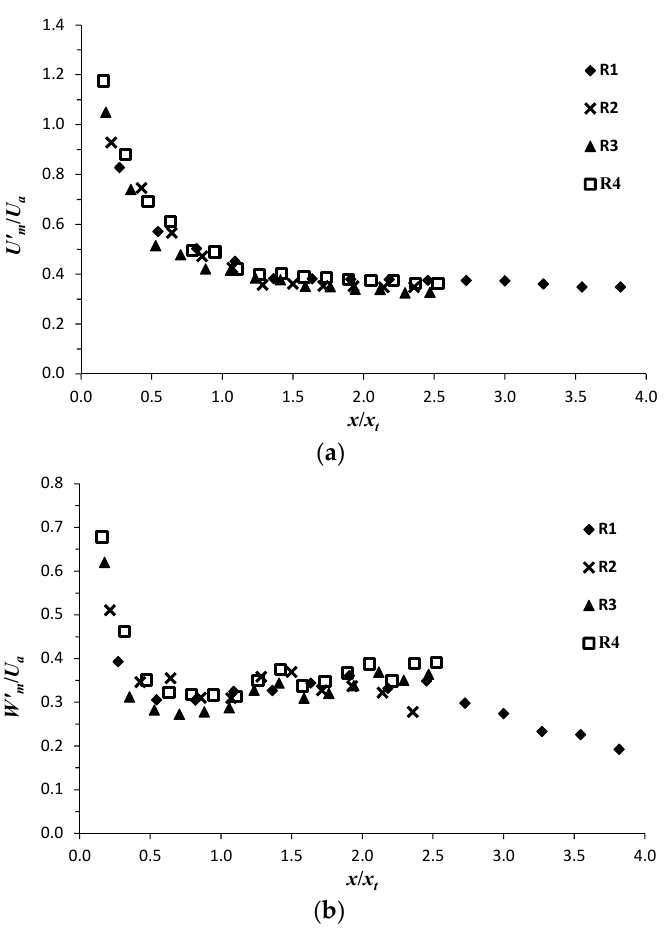
Figure 10. Decay/rise of the maximum turbulence intensity as a function of the downstream position x / x t : ( a ) U’ m / U a ; ( b ) W’ m / U a .